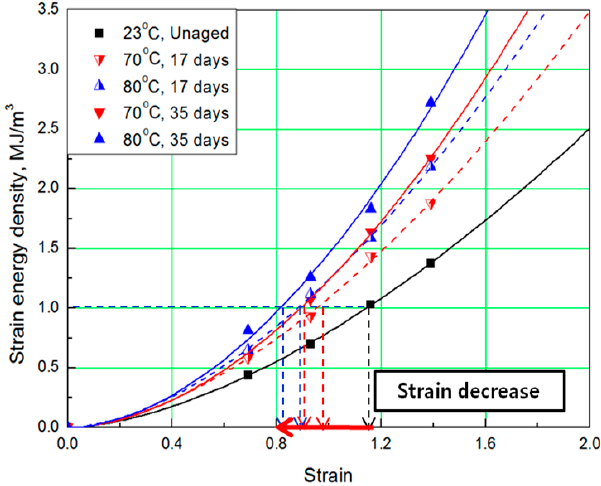
Figure 3. Strain energy density (SED)-strain curves according to aging time.